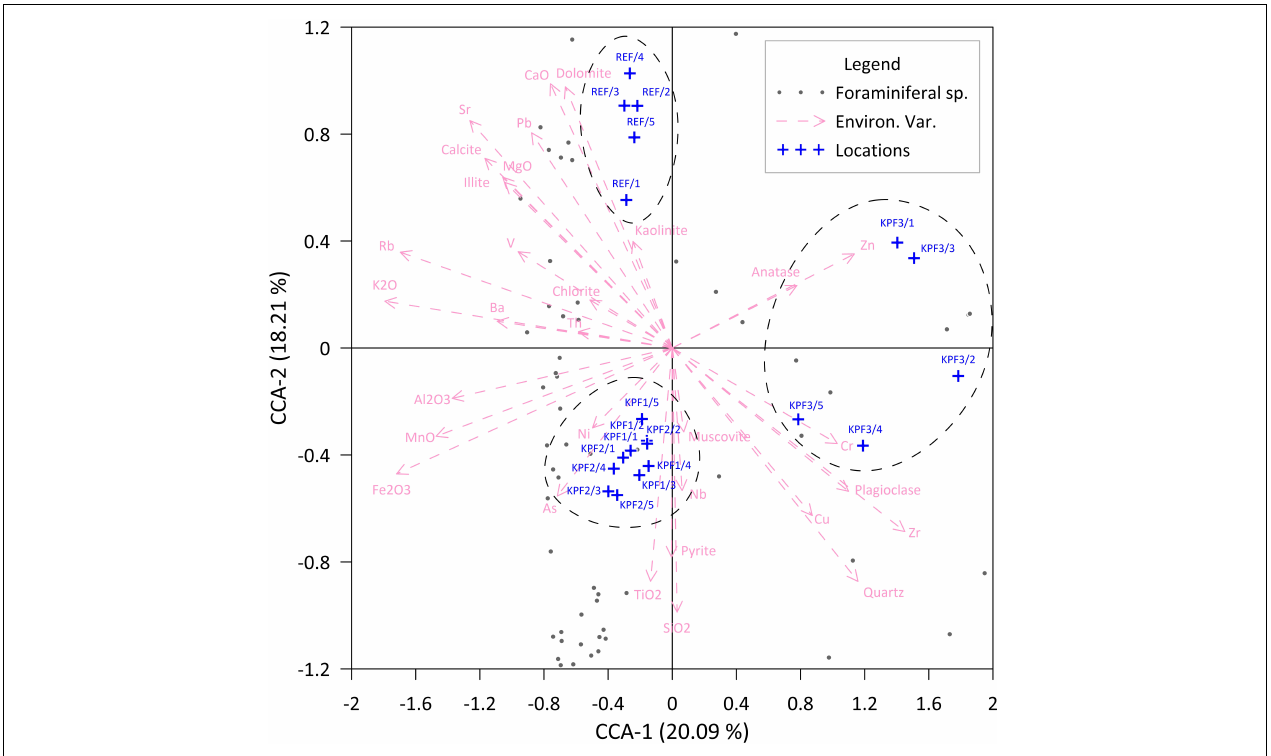
FIGURE 5 | Canonical correspondence analyses (CCA) of total foraminiferal assemblages, and mineralogical and geochemical data in sediment samples from four locations (KPF1, KPF2, KPF3, and REF) from Bay of Koper. grouped the samples into three main groups: the first